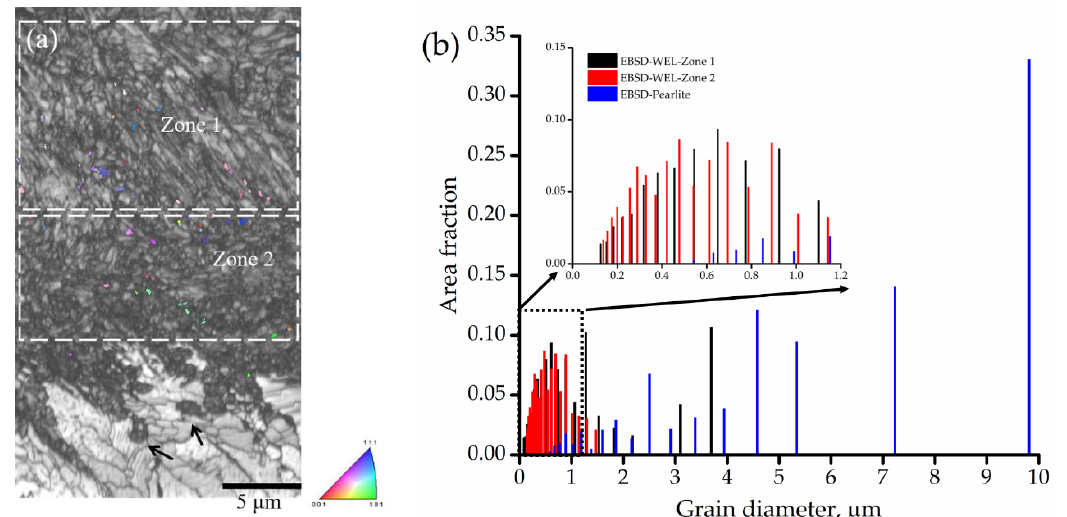
Figure 3. ( a ) The image quality map of WEL superimposed on the inverse pole figure map of austenite. Part of the pearlite beneath the WEL is also included in the mapping; ( b ) comparison of the grain diameter associated with zone 1 and zone 2 in ( a ) and the pearlite area.